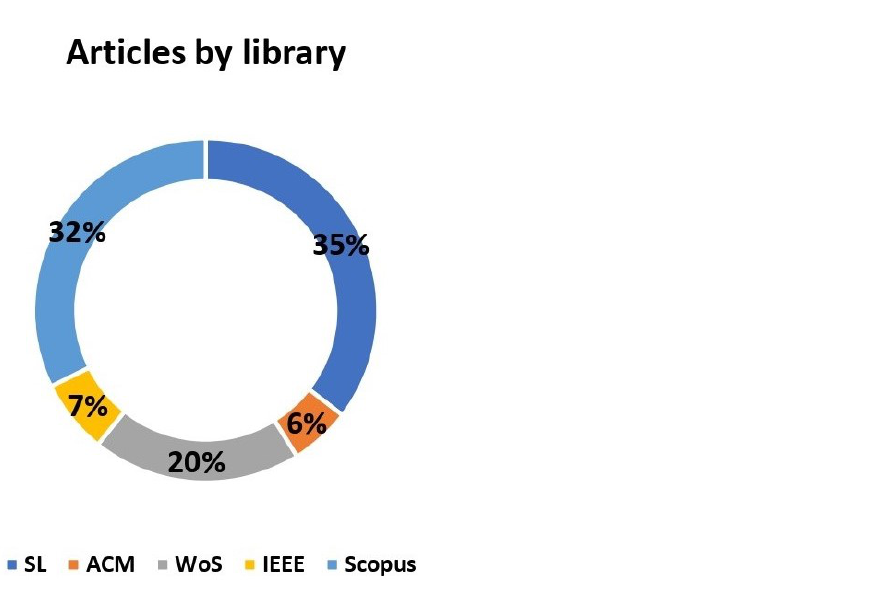
Figure 2. Percentage of articles by libraries (at the end of the